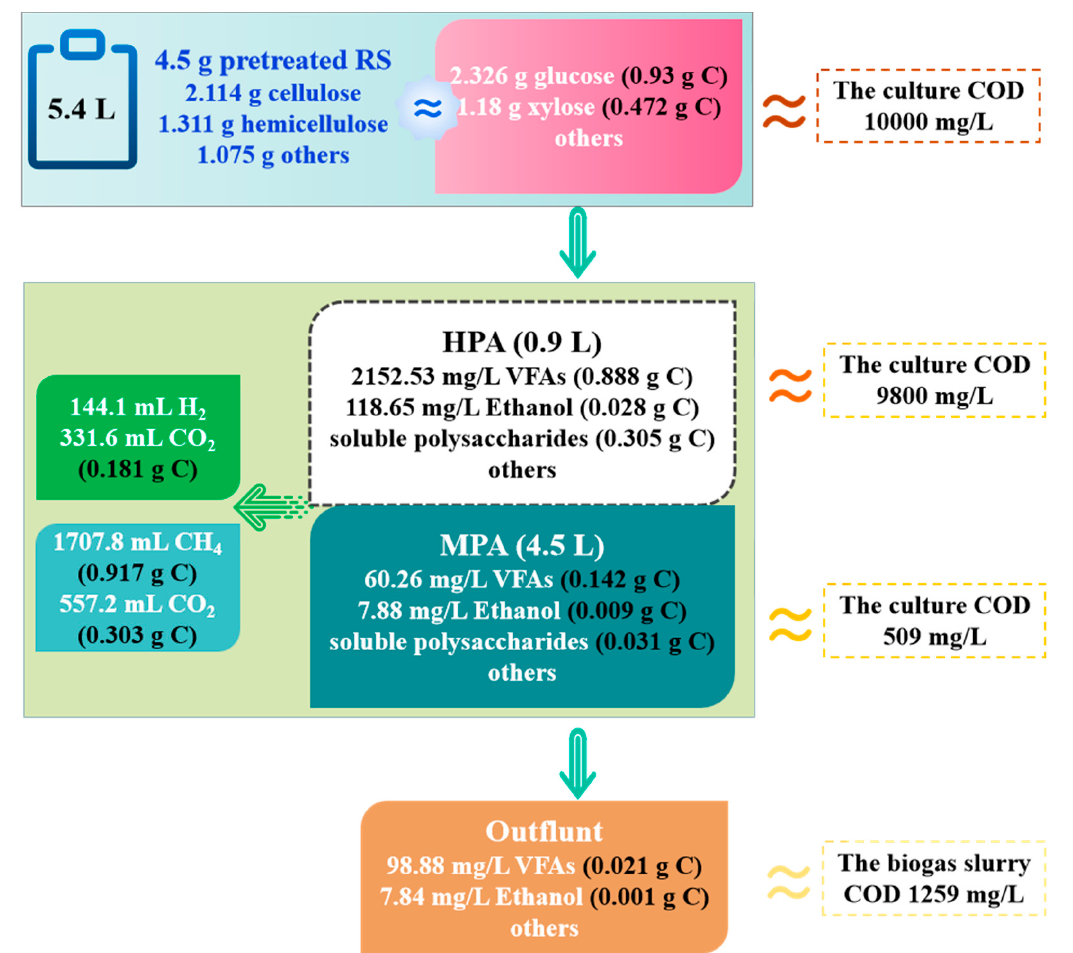
Figure 6. The carbon distribution during biohythane production process .